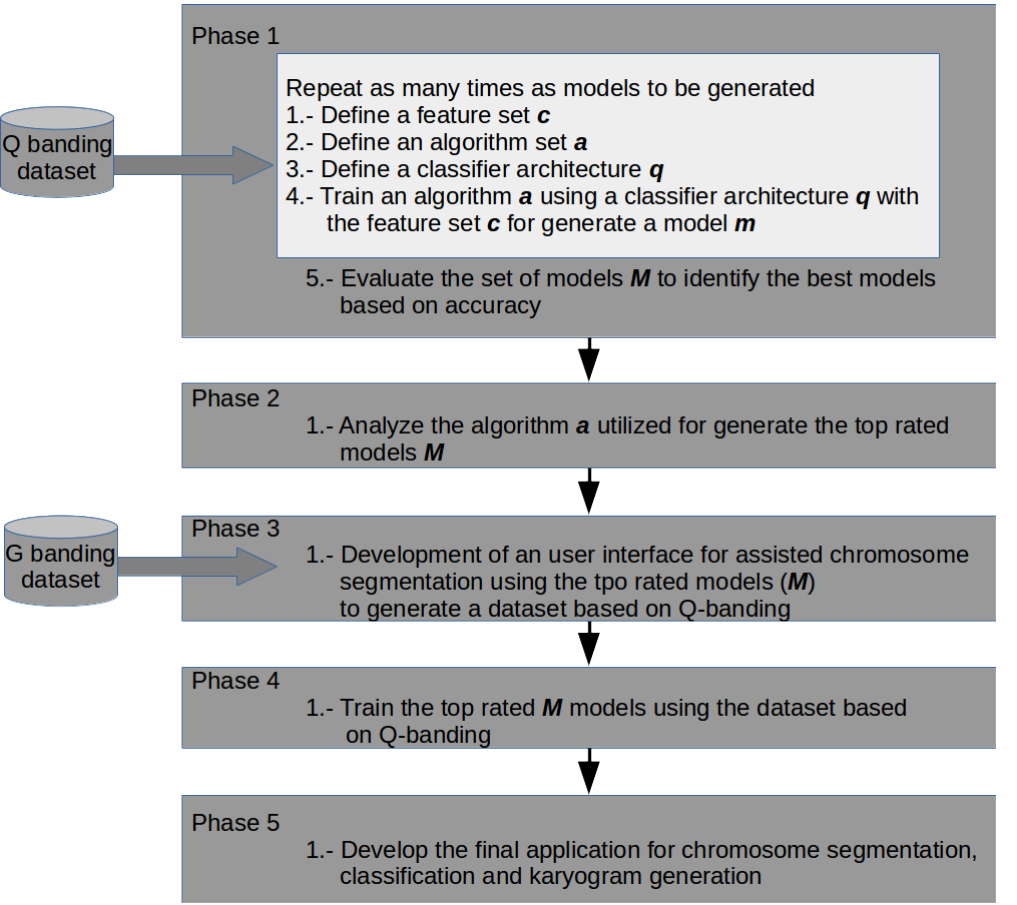
Figure 4. Schematic representation of the required phases to generate a model to classify G-band chromosome images and build a